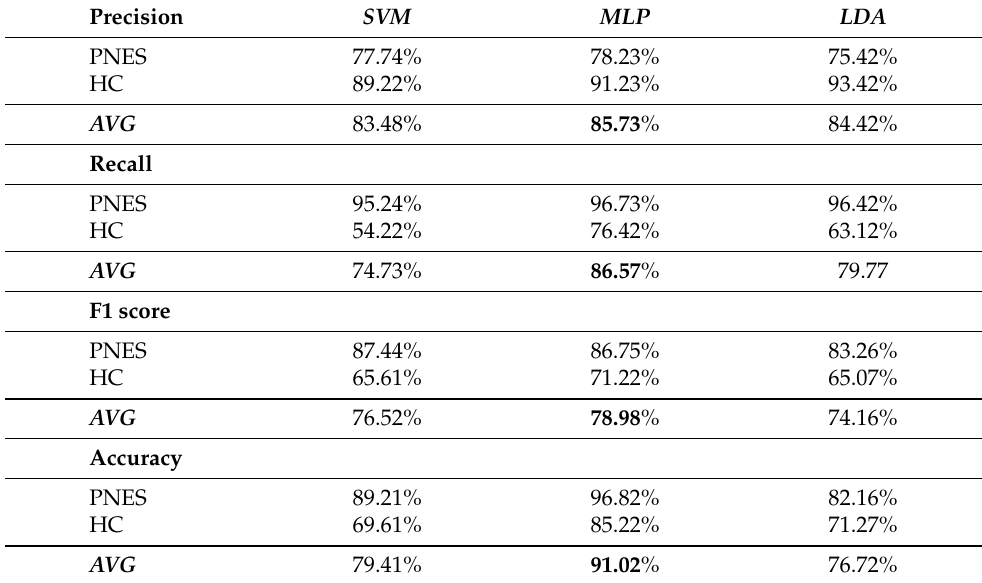
Table 2. Binary classification performance ( Precision, Recall, F1 score, and Accuracy) of SVM, MLP, and